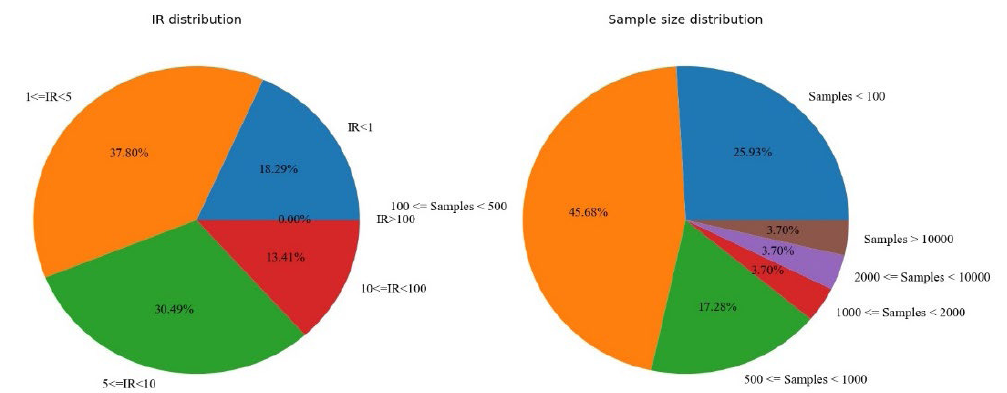
Figure 3. Data distribution of SDP